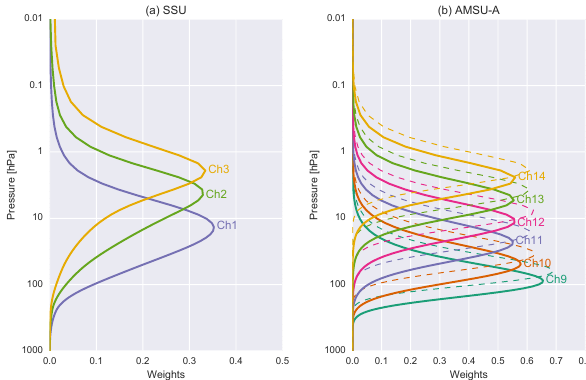
Figure 7. Vertical weighting functions of radiance measurements for (a) the TOVS-suite Stratospheric Sounding Unit (SSU) in- strument (1979–2005) channel 1 (centred at ∼ 15hPa), channel 2 ( ∼ 5hPa), and channel 3 ( ∼ 1.5hPa) and (b) the ATOVS-suite Ad- vanced Microwave Sounding Unit A (AMSU-A) instrument (1998– present) temperature channels 9–14 at near-nadir (1.67 ◦ , solid lines) and limb (48.33 ◦ , dashed lines) scan positions. SSU channels 1 through 3 may also be referred to as TOVS channels 25 through